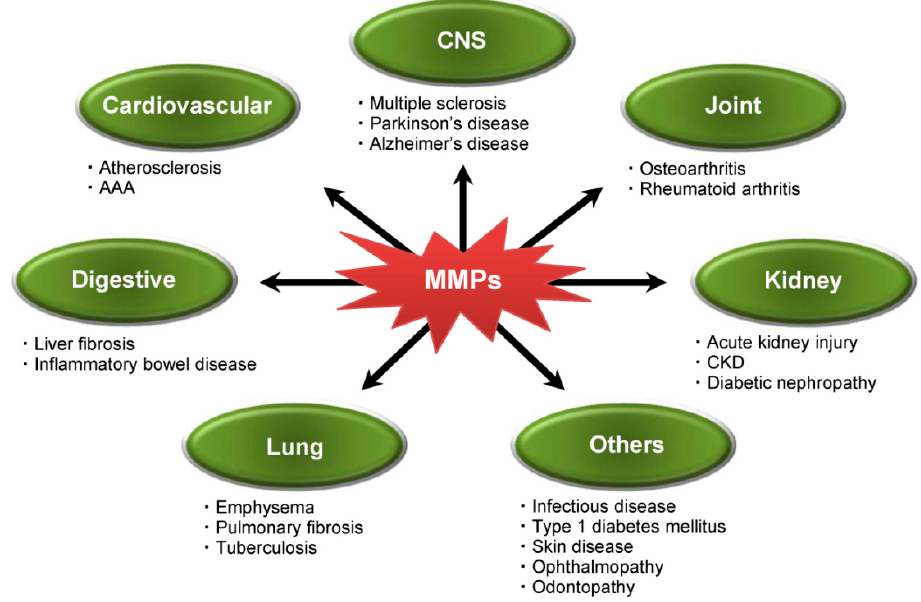
Figure 1. Involvement of matrix metalloproteinases (MMPs) in non-neoplastic disorders. AAA, abdominal aortic aneurysm; CKD, chronic kidney disease.